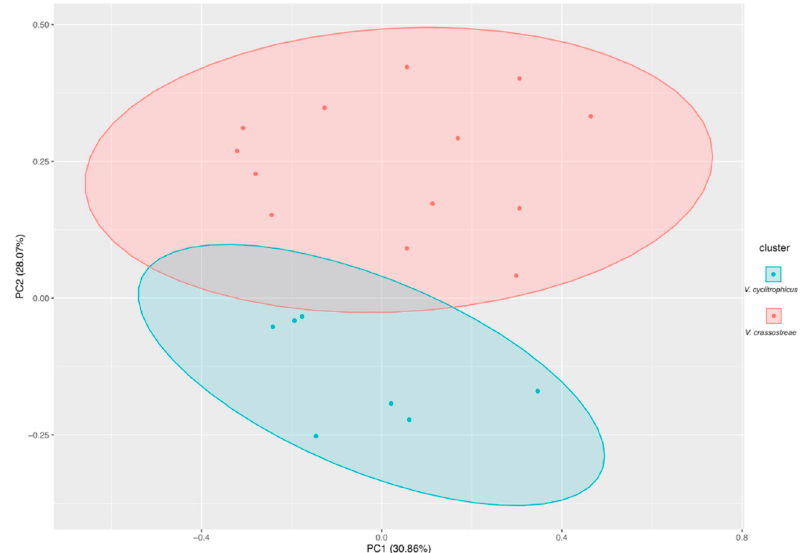
Figure 5. Principal component analysis of biochemical features of Vibrio spp. strains based on molecular species identification. The red cluster contains most of the strains that belonged to V. crassostreae , whereas the blue cluster contains V. cyclitrophicus . Confidence ellipses (95%) plot convex hull values of each cluster.